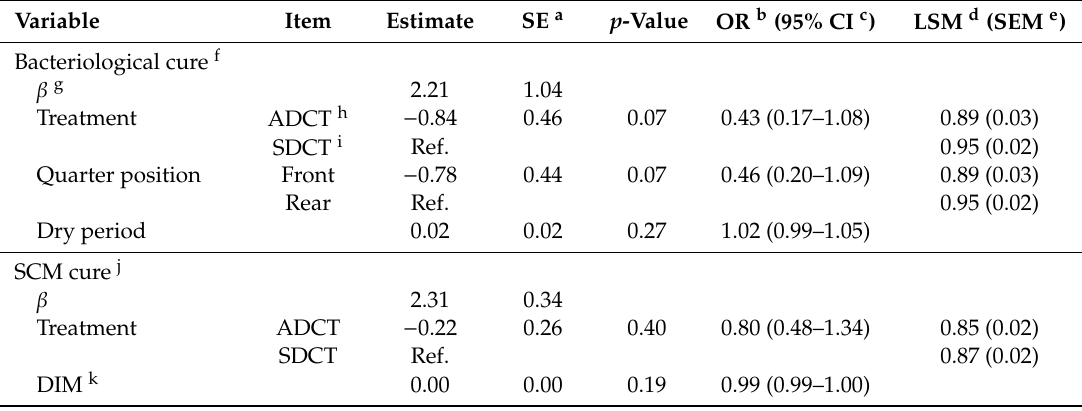
Table 4. Results of logistic regression for the e ff ect of dry-o ff protocols on mammary gland health indicators (bacteriological and SCM cure and new cases of